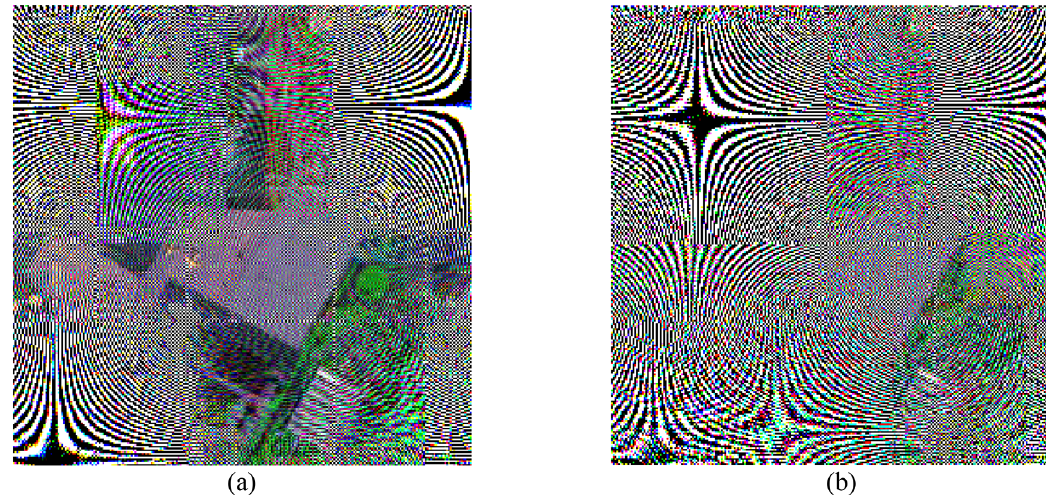
Figure 11. The test of occlusion attack: ( a ) the attack result of 1/16 occluded and ( b ) the attack result of 1/8 occluded.